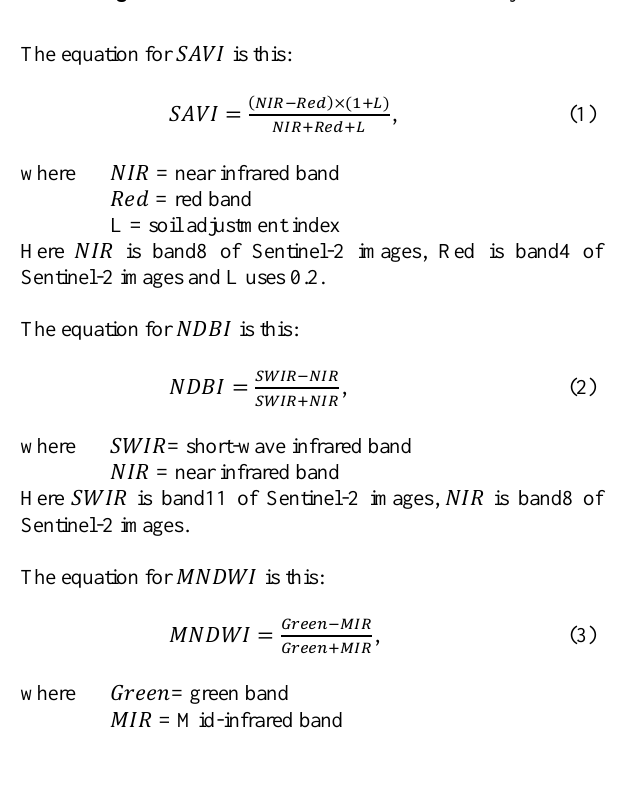
Figure 2 . Flowchart of the method in the study.